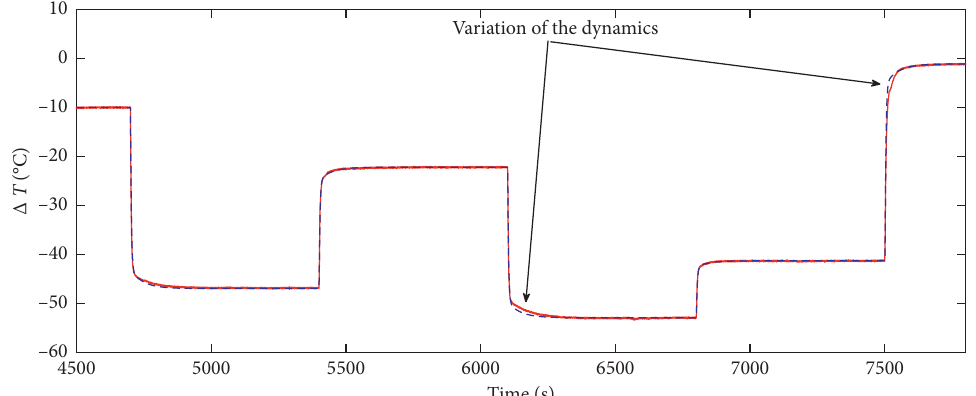
Figure 25: Variation of the dynamics detected on estimation dataset for the thermal process. Red: output of the thermal process. Blue dashed line: output of the estimated model.